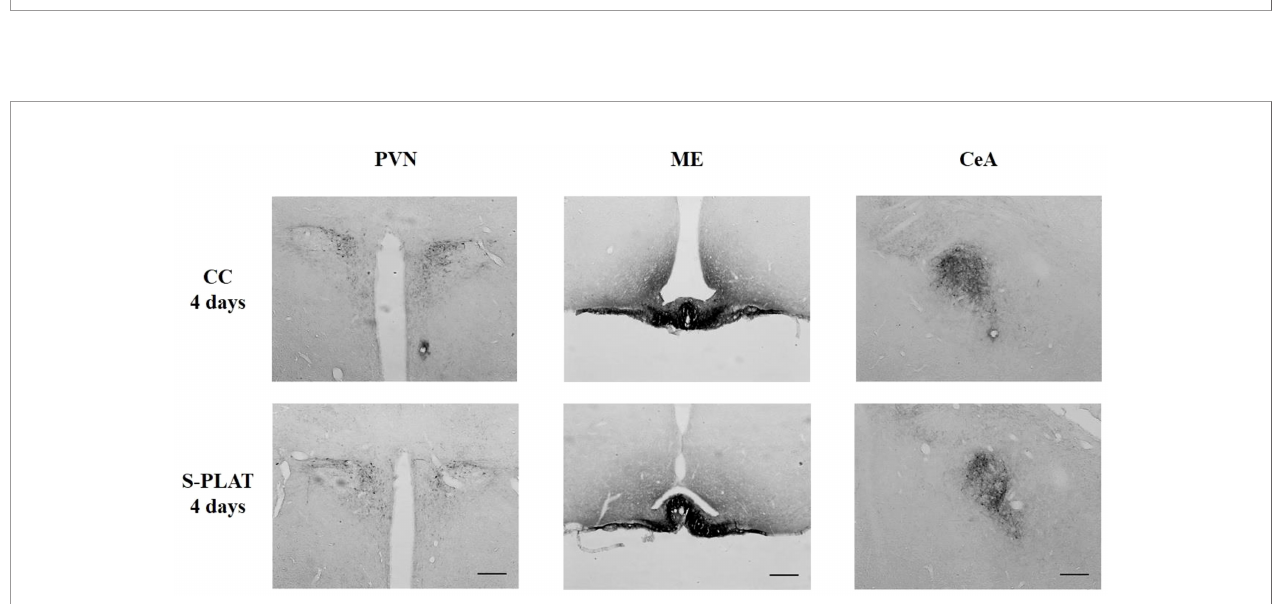
FIGURE 4 | Representative photos of CRH immunocytochemistry in the PVN (left), in the external zone of the ME (middle) and CeA (right) of one control (CC) and one rat submitted to 4 days of paradoxical sleep deprivation (S-PLAT). Scale bar = 200 m m.